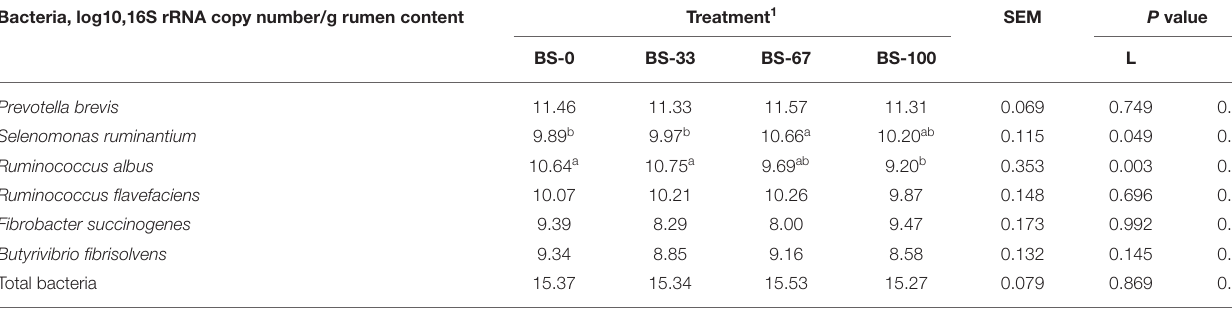
TABLE 6 | Effects of dietary barley starch proportions on the relative abundances of rumen bacteria ( n = 10). Bacteria, log10,16S rRNA copy number/g rumen